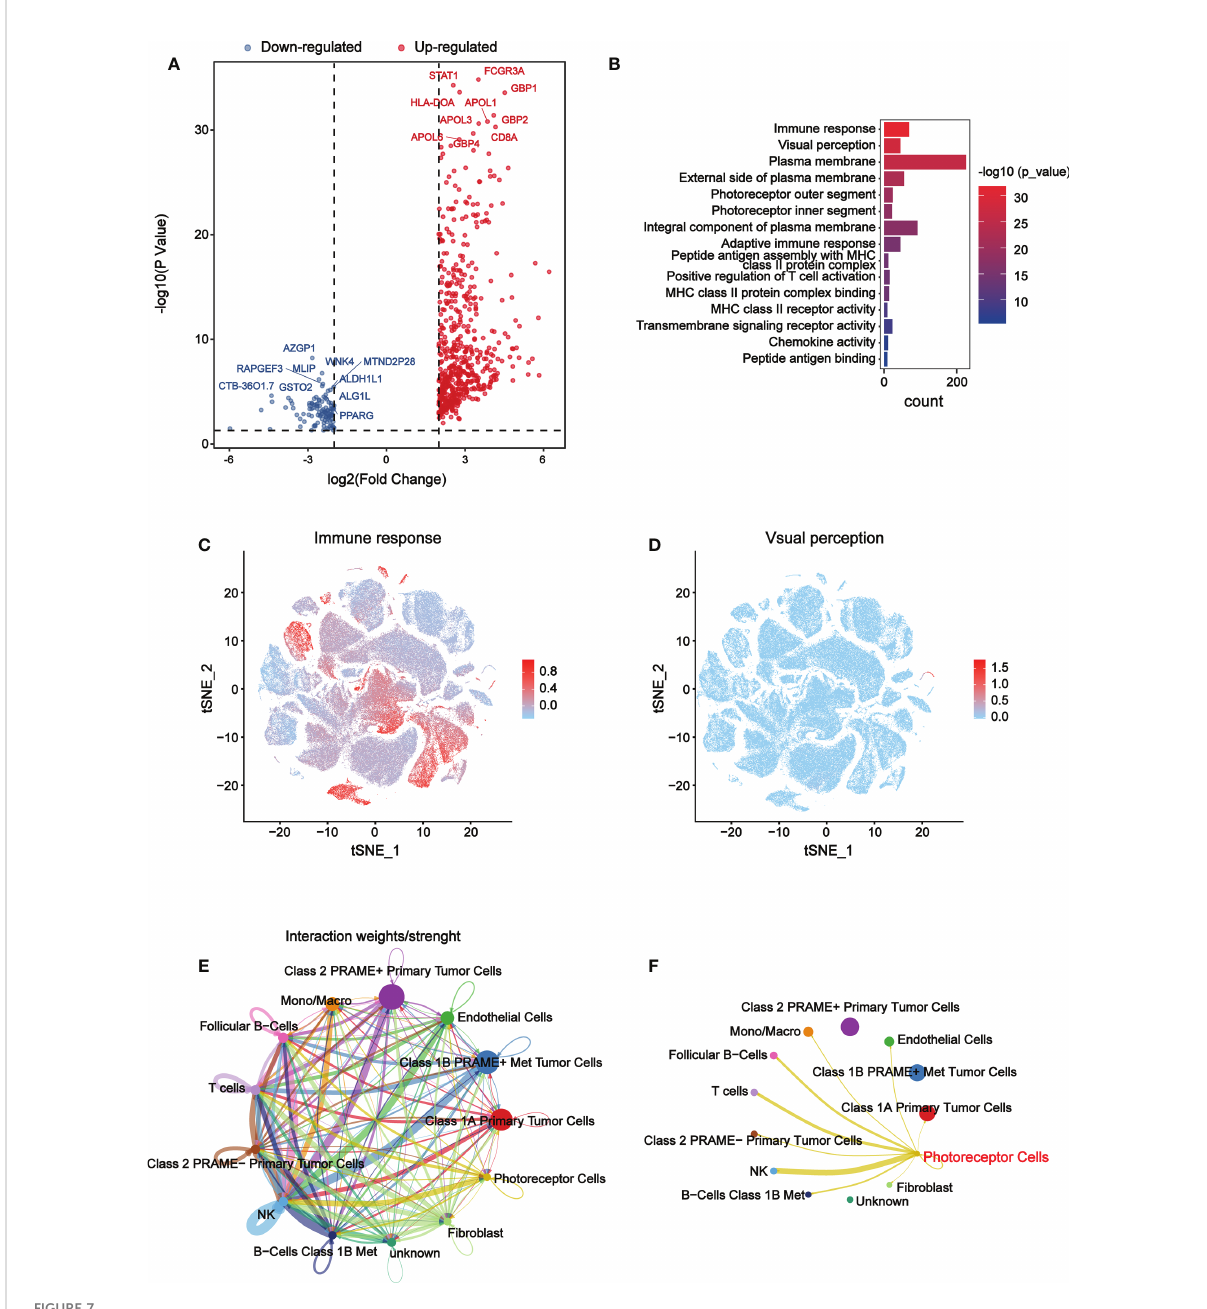
FIGURE 7 Main functions affected by B7 family. (A) Volcano plot was drawn to identify DEGs affected by B7 members. The Y axis is the value of fold change of expression level that based on the logarithmic ratio (mean of changed expression/mean of unchanged expression). -log10 p-value > 1.3 and log ratio > 2 or log ratio< -2 is considered to be signi fi cantly different. (B) The most signi fi cant functions were shown according to P value and gene count. The overall expression distribution of DEGs in immune response function (C) and visual perception function (D) in 13 cell types. (E) An overview of cell-cell interactions in 13 cell types. Arrow and edge color indicate direction. Edge thickness indicates the weights/ strength of interaction between cells. (F) cell-cell interactions map between photoreceptor cells and other 12 cell